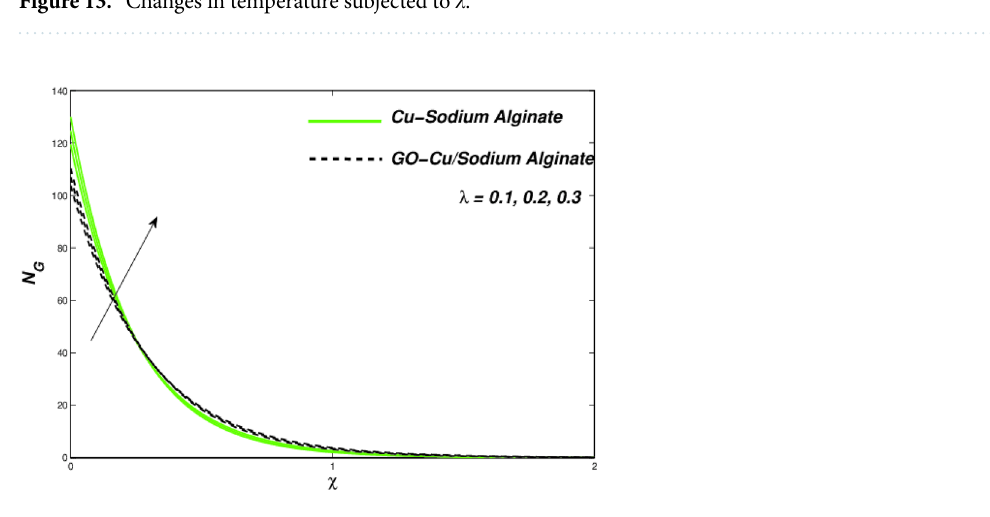
Figure 14. Entropy variation versus (cid:31)